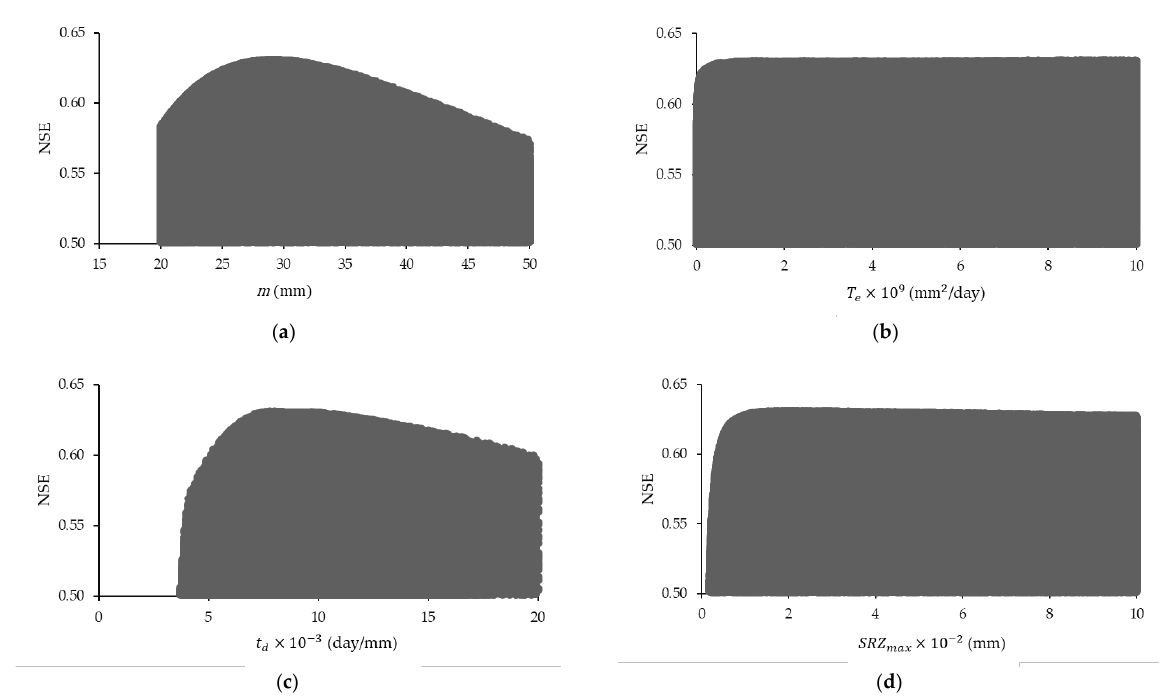
Figure 6. Scatter plots of NSE values versus the corresponding parameter values for TOPMODEL parameter sets that were got during the model calibration period. Each dot represents a separate parameter value from a given parameter set. Only simulations with an NSE value of at least 0.5 are shown. ( a ) A scatter plot of NSE versus values of parameter m ; ( b ) A scatter plot of NSE versus values of parameter T e ; ( c ) A scatter plot of NSE versus values of parameter t d ; ( d ) A scatter plot of NSE versus values of parameter SRZ max .